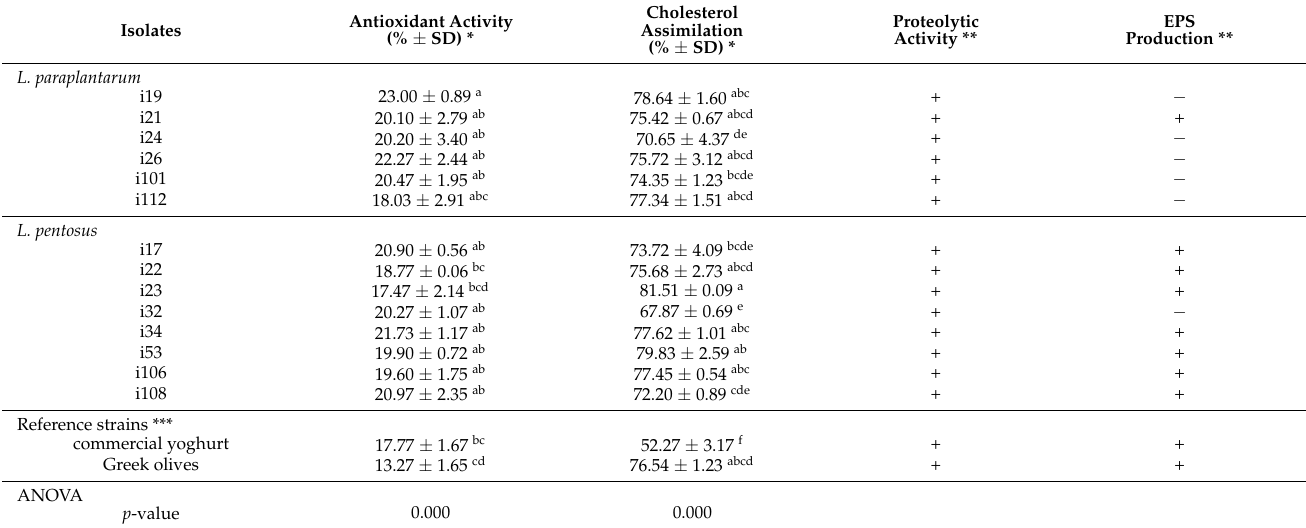
Table 5. Performance of L. pentosus and L. paraplantarum strains pertaining to antioxidant activity, cholesterol assimilation, proteolytic activity, and EPS